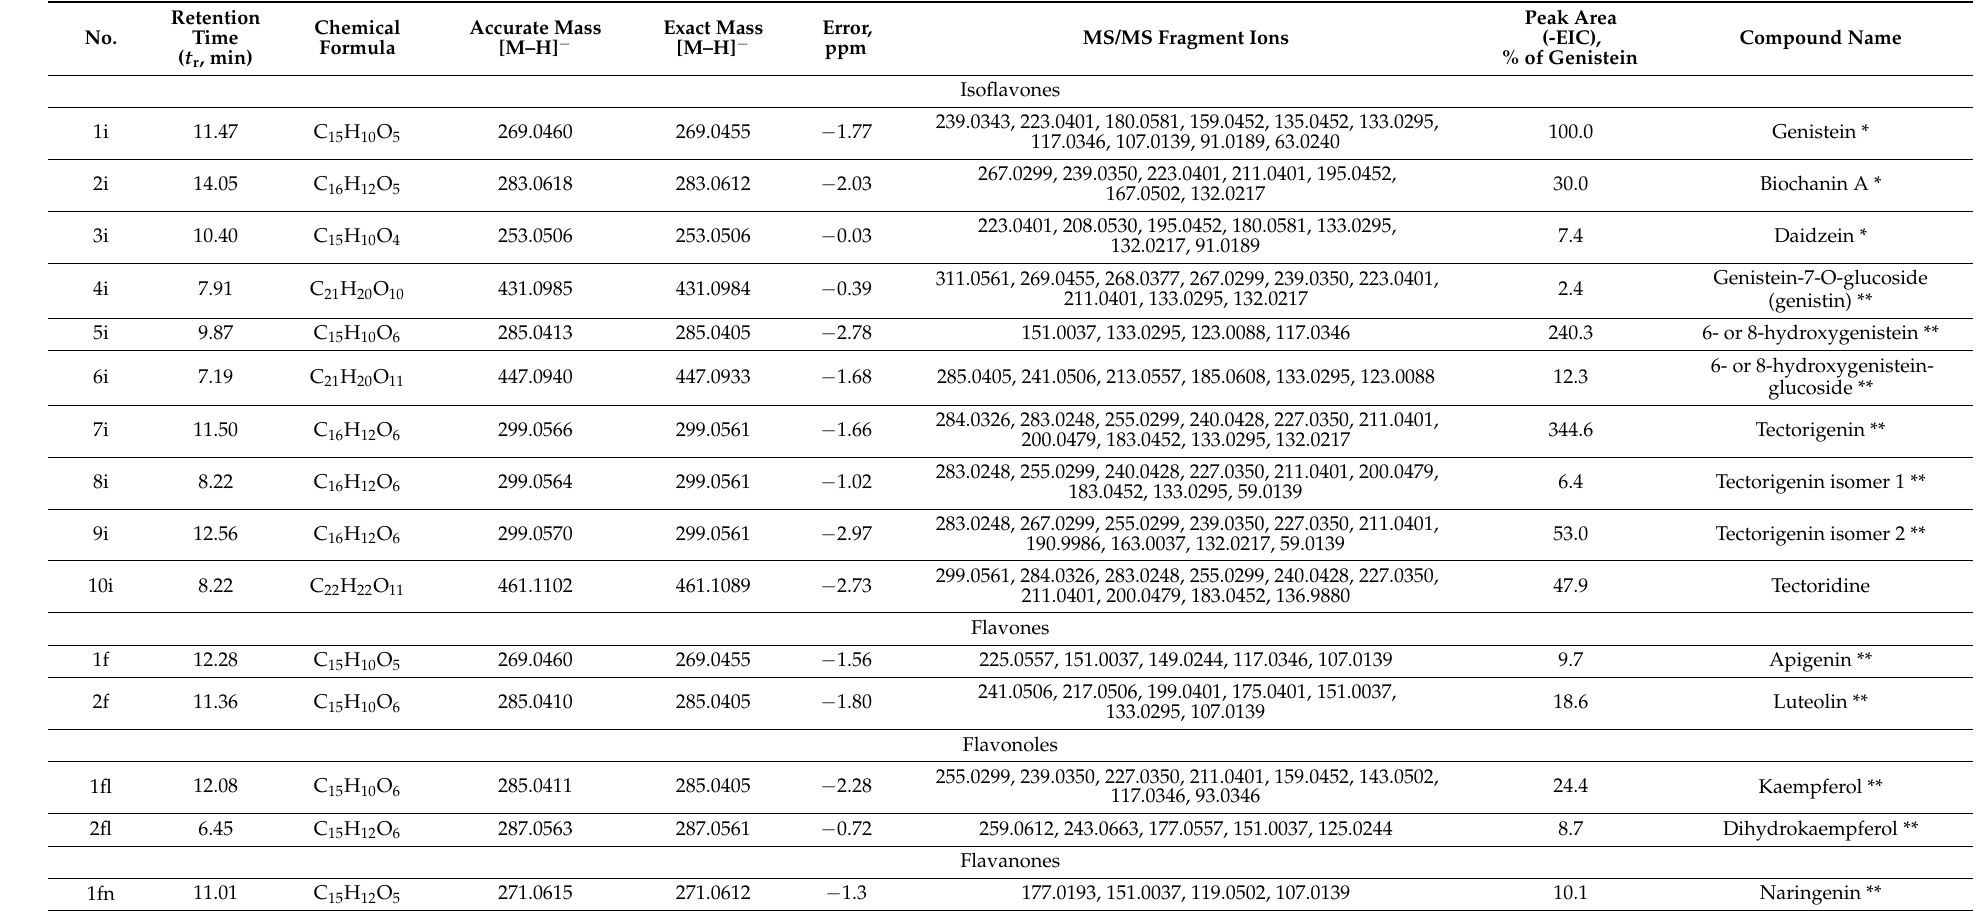
Table 2. Major flavonoids identified in the extract of kudzu flower using